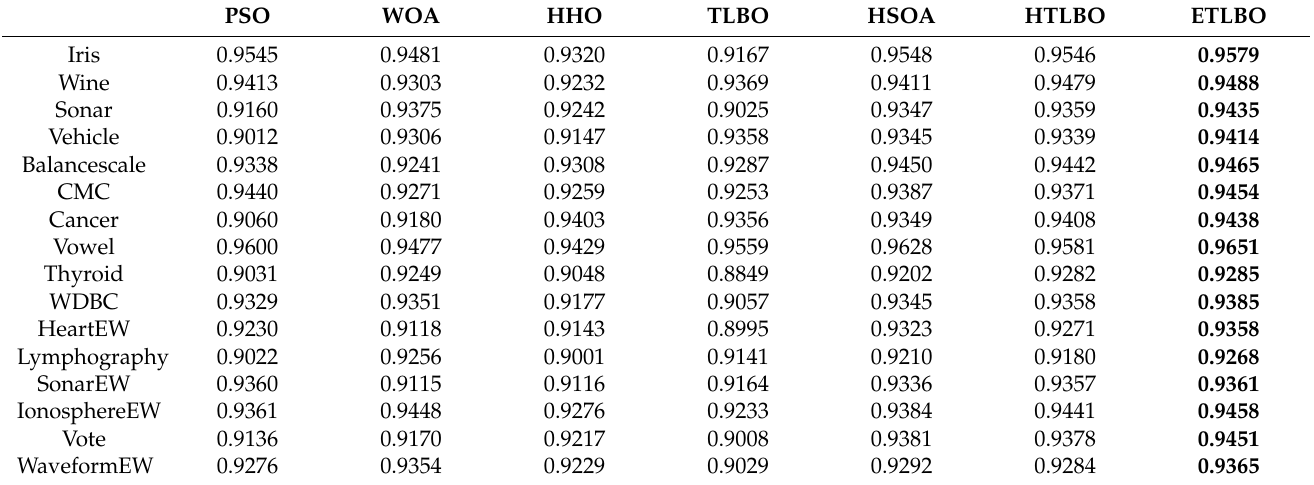
Table 6. The classification accuracy of compared algorithms.